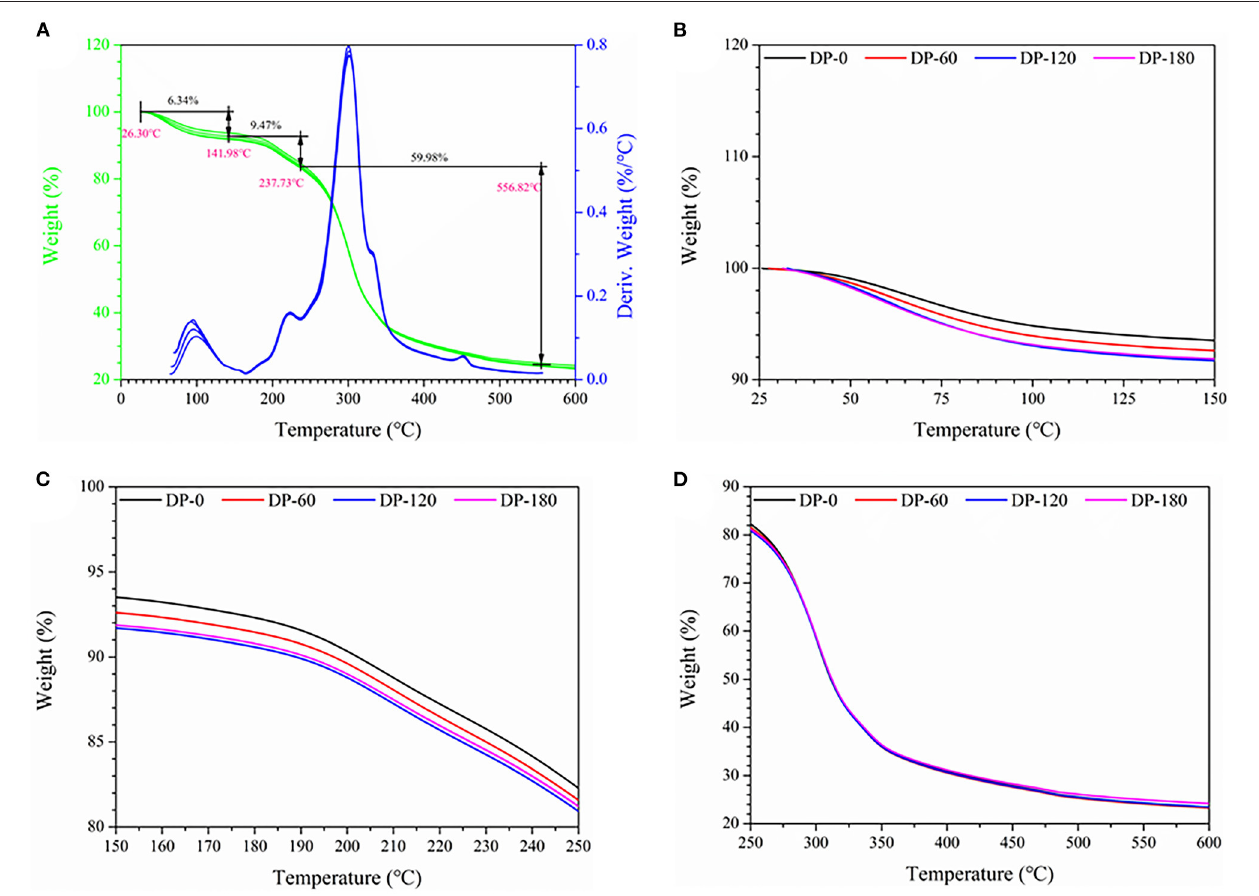
FIGURE 7 | The thermal gravimetric curves of RPA in the DP-0, DP-60, DP-120, and DP-180 groups: (A) (25–400 ◦ C), (B) (25–150 ◦ C), (C) (150–250 ◦ C), and (D) (250–600 ◦